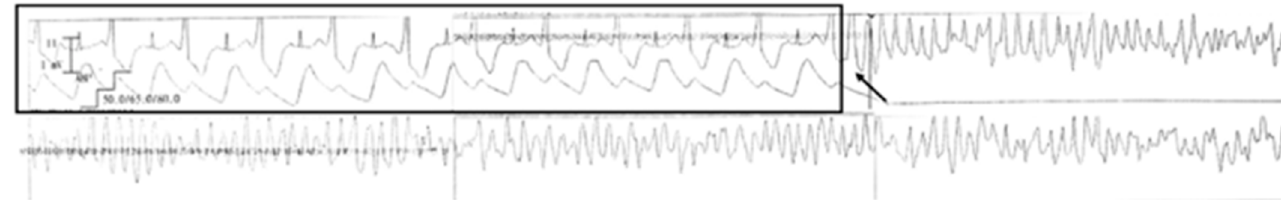
Figure 3. ECG rhythm strip on fifth postnatal day showing bigeminy PVC (window), followed by an R-on-T event (arrow) that initiated the TdP.